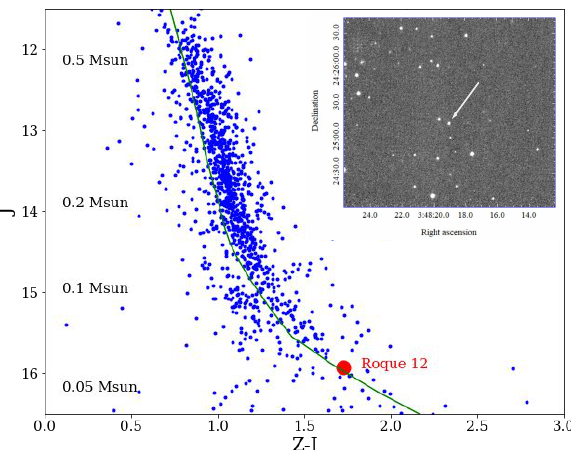
Fig. 1.— Colour-magnitude diagram from the UKIDSS/GCS photometry published by Lodieu et al. (2012). The position of R12 is marked. A 120Myr model isochrone (assuming a distance of 134pc) with mass scale is overplotted (Baraffe et al. 2015). The inset shows a 3 × 3 arcmin finding chart for R12, from the UKIDSS J-band